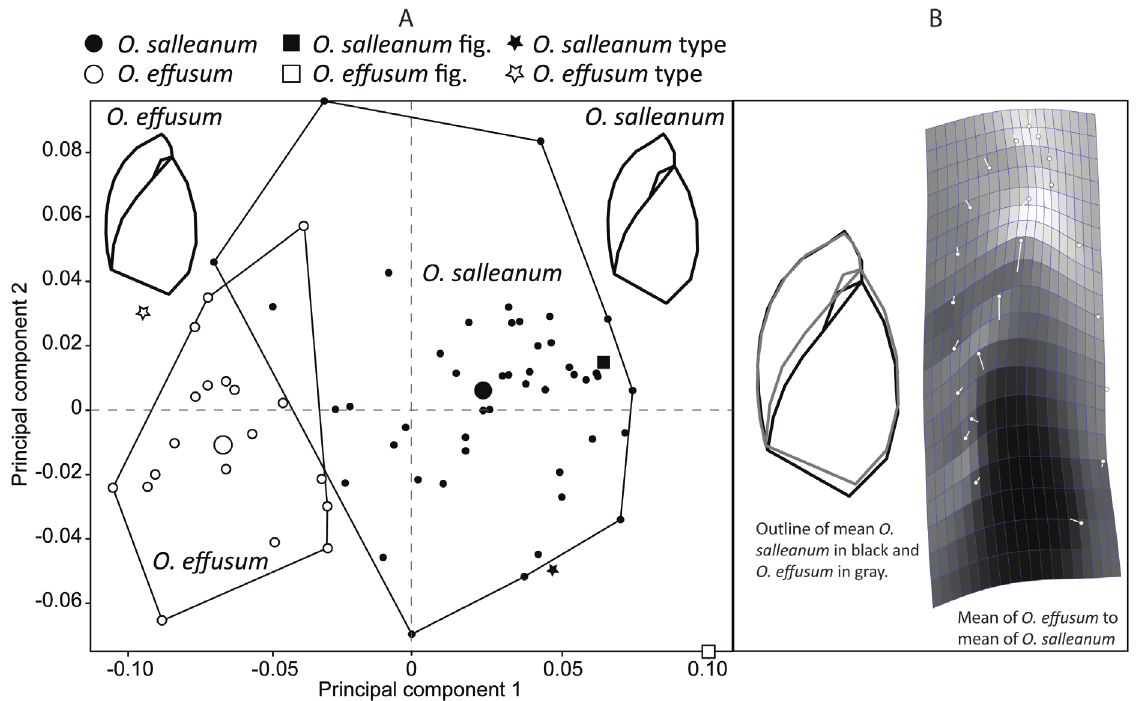
Fig. 4. A . Plot of principal component analysis on Oxyloma effusum (L. Pfeiffer, 1853) (n = 19) and O. salleanum (L. Pfeiffer, 1850) (n = 46) shells collected from the type localities. Landmarked types and original figures are included for each species. Convex hulls are drawn from non-type shells examined. The centroid means of each species shown with oversize symbol. Outline drawings represent the mean form of each nominal species compared to the overall mean shape. B . The outlines of the two nominal species superimposed with O. salleanum in black and O. effusum in gray. The heat map deformation grid shows the shape change from the mean form of O. effusum to the mean form of O. salleanum . Vectors on landmarks show the direction and magnitude of